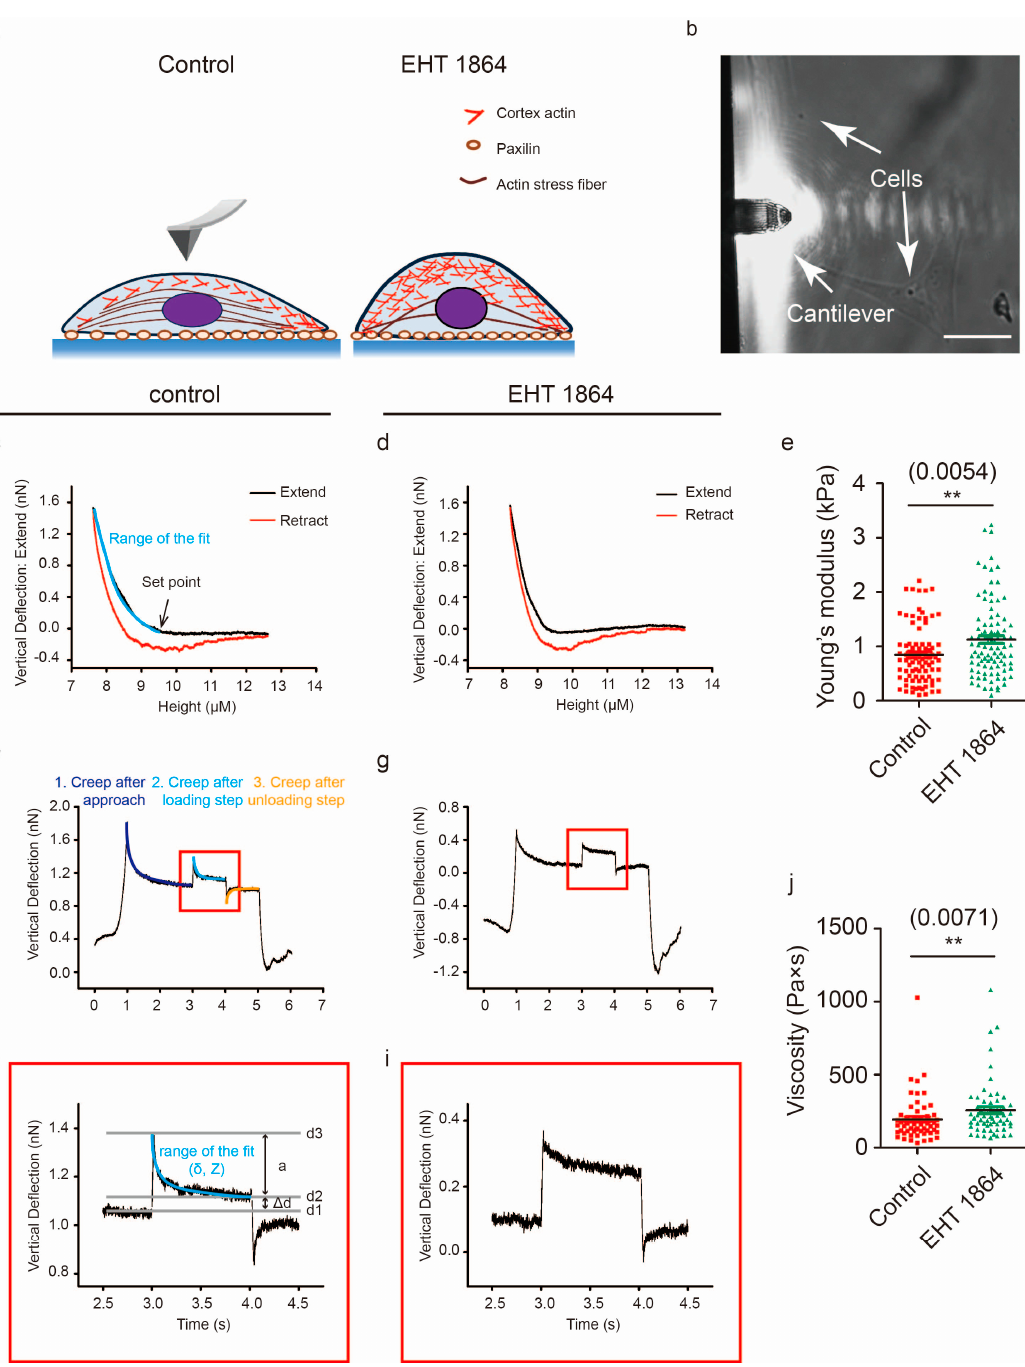
Figure 7. Rac1 activation affects the mechanics of GBM cells. ( a ) Diagrams illustrate the method of application of external force. ( b ) Image showing the AFM detection of the cell mechanical properties of a single living cell. ( c,d ) Exemplary force curve recorded on a U87 cell with ( d ) and without ( c ) EHT 1864 incubation for 1–2 h. The black solid line represents the approach curve, and the Young’s modulus (E) was calculated by fitting the approach curve of each cell. ( e ) Histograms of the associated Young’s modulus E for U87 cells with and without EHT 1864 treatment. ( f–i ) Typical creep curve responses to a cell after applying the z step. The z height is first ramped as in a conventional force curve (approach ramp) and then kept constant for 1 s. ( j ) Histograms of the viscosity value of U87 cells with and without EHT 1864 treatment. Cell number: 95 in control group and 101 in EHT 1864-treated group for Young’s modulus; 64 in control group and 66 in EHT 1864-treated group for viscosity. **: p < 0.01; scale bar: 25 µ